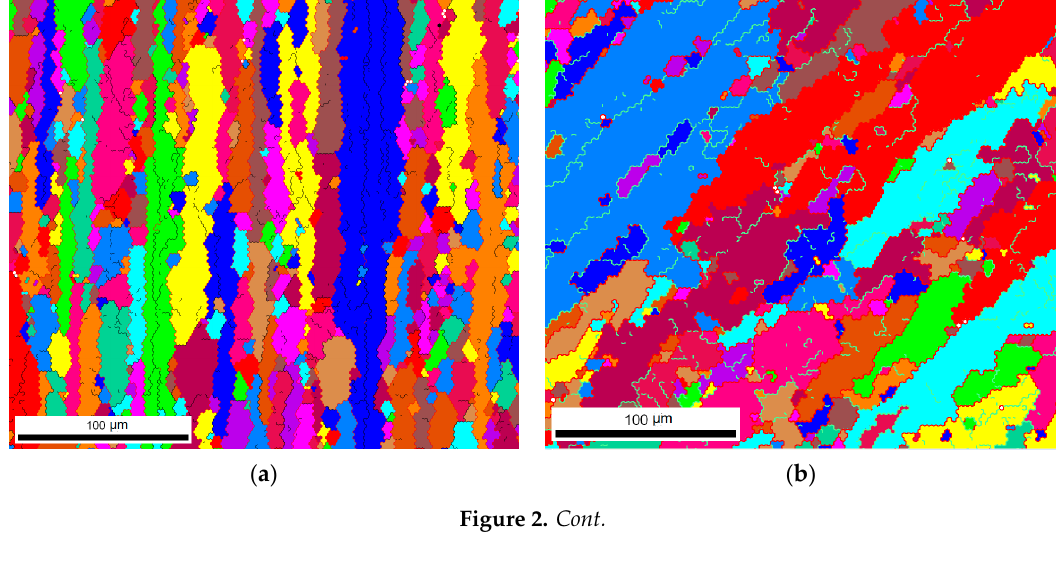
Figure 2. EBSD (Electron Back-scattering Patterns) images for different characteristic area: ( a ) IPF (Inverse Pole Figure) of BM (Base Metal); ( b ) IPF of HAZ (Heat Affected Zone); ( c ) and ( d ) IPF and back contrast image of TMAZ (Thermo-Mechanically Affected Zone), respectively; ( e ) and ( f ) IPF